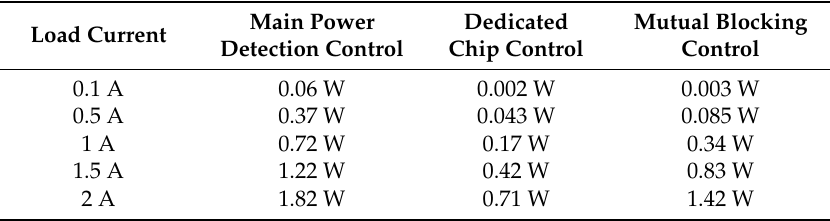
Table 2. Power loss of power PMOS or diode under different load current.